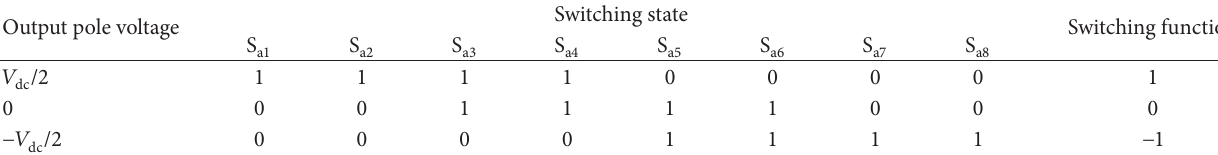
Table 3: Switching states of three-level inverter.